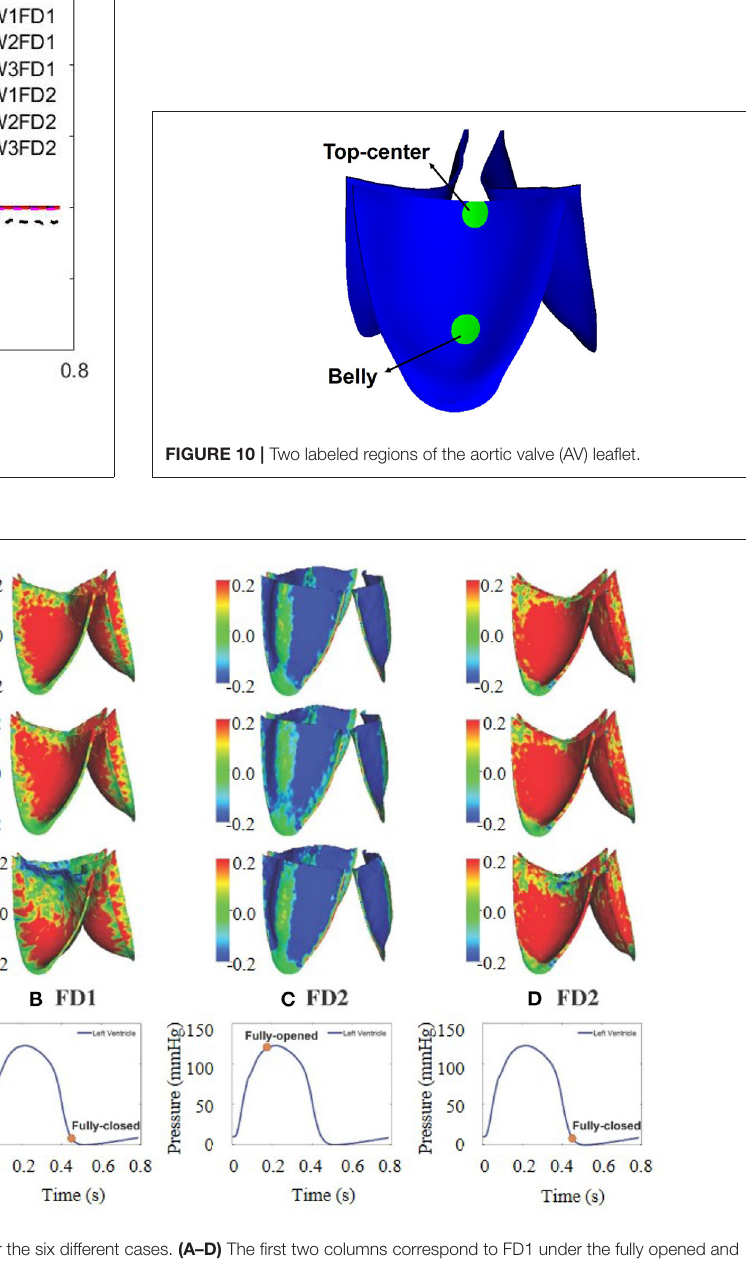
Frontiers in Physiology |